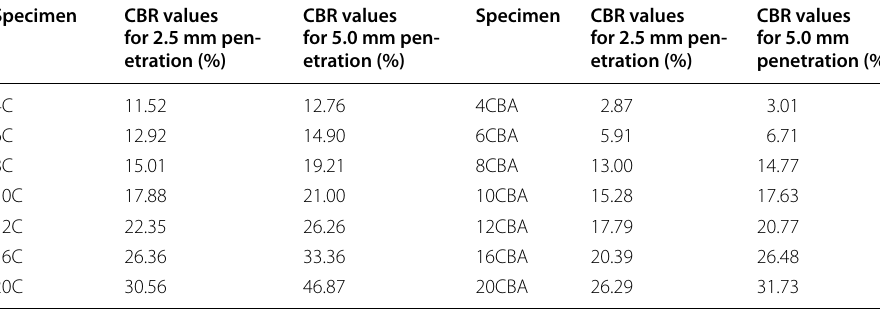
Table 6 CBR values at different cement and cement–bottom ash mix contents